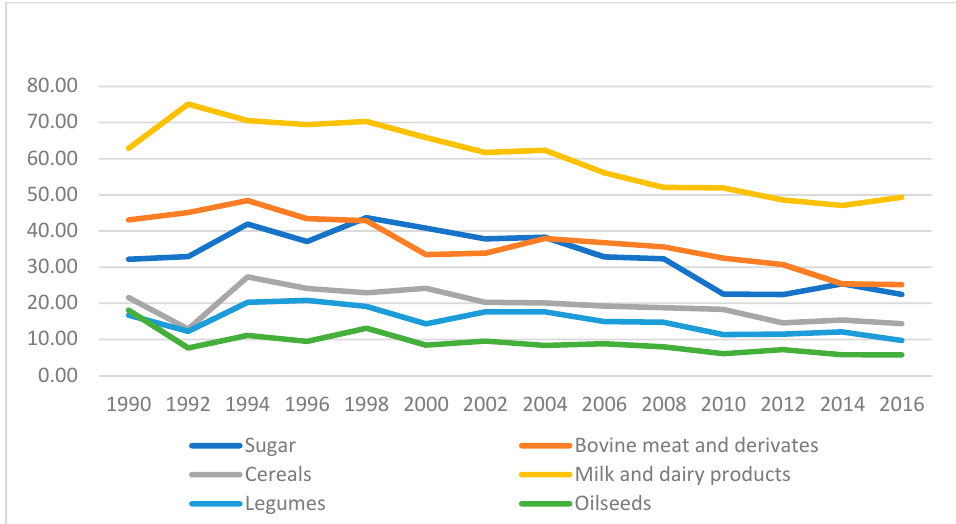
Figure 5. European share in world exports of continental products. Source: own elaboration from data obtained from UN Comtrade Database.